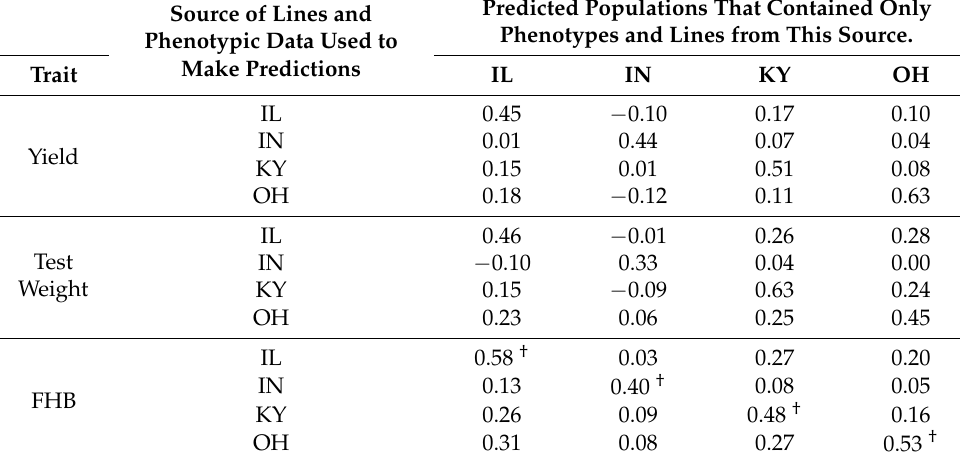
Table 5. Accuracy of genomic selection within and between each of four soft winter wheat breeding programs (IL, IN, KY, OH) for grain yield, test weight, and resistance to Fusarium Head Blight (FHB). Shaded diagonal elements are from ten-fold cross-validation accuracy of genomic selection within programs using data from just the lines and phenotyping trials of that program. Off-diagonal elements are the correlation of the observed phenotypes of lines from one program obtained from that program’s testing, with their predicted value derived from genotypic and phenotypic data from lines from another program’s testing. The phenotypic data for the training population was obtained from multiple years of trials conducted within each program. Predicted Populations That Contained Only Source of Lines and Phenotypes and Lines from This Source. Phenotypic Data Used to Make Predictions Trait IL IN KY OH IL 0.45 − 0.10 Yield